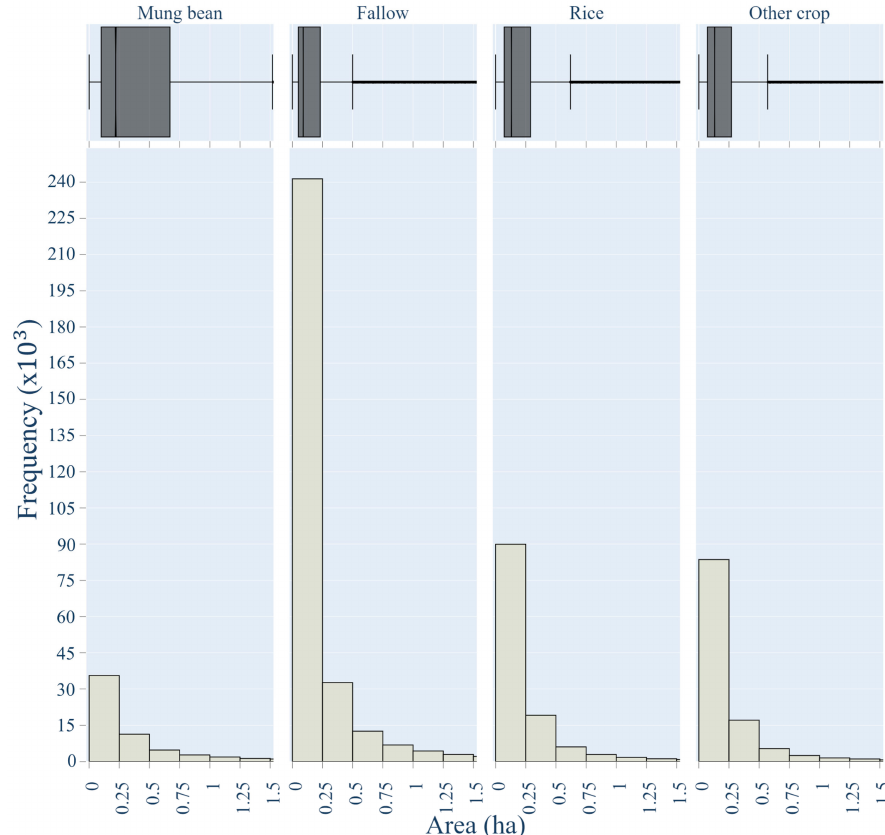
Figure 10. Histograms and box and whisker plots of the areas of contiguous patches grown with the same crop type identified during the mung bean growing season from February 6 through April 17, 2019 in Barisal division of Coastal Bangladesh. The patches were created by merging segments with common borders labeled with the same crop